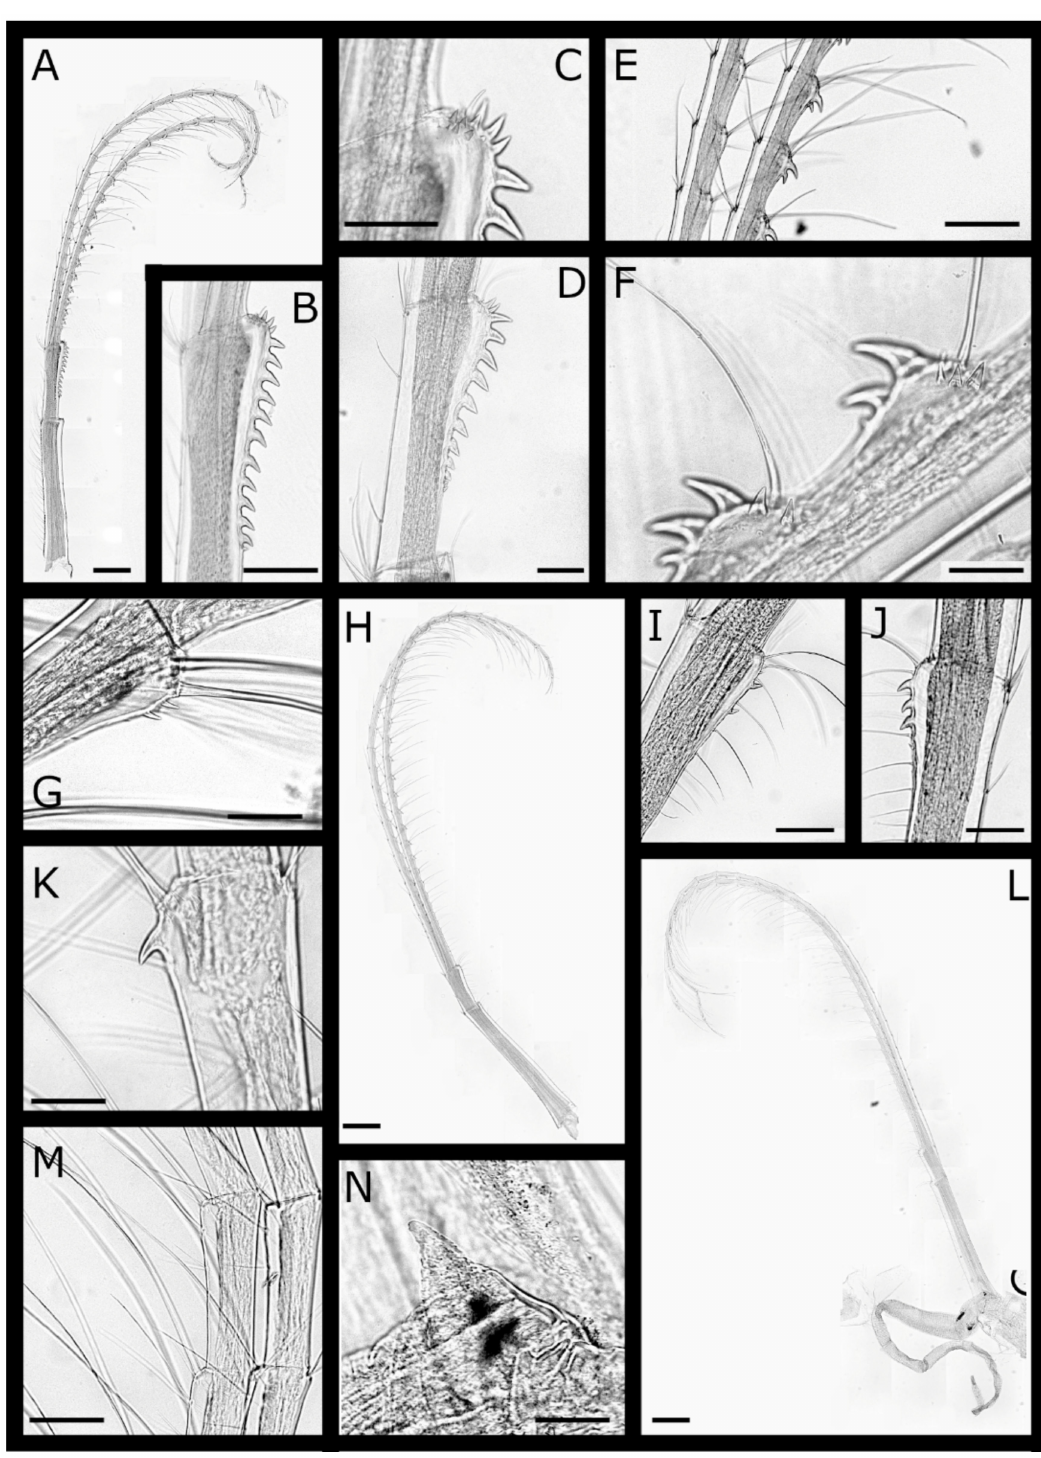
Figure 16. Euacasta excoriatrix sp. nov. cirri IV–VI and penis (A–C, E–M WAM C71800, holotype; D, WAM C61475, paratype). ( A ) left cirrus IV; ( B ) basis of cirrus IV protopod; ( C ) close up of anterodistal angle of same; ( D ) basis of cirrus IV protopod; ( E ) medial segments of cirrus IV anterior and posterior rami; ( F , G ) detail of teeth and erect spines on segments of cirrus IV anterior ramus; ( H ) left cirrus V; ( I,J ) teeth on distal portion of left and right cirrus V protopod; ( K ) tooth on medial segment of right cirrus V; ( L ) left cirrus VI and penis; ( M ) medial segments of cirrus VI anterior and posterior rami; ( N ) basidorsal point of penis. Scale bars: A, H, L = 400 µ m; B, D–E, I–J, M = 100 µ m; C, F, G, K, N = 50 µ